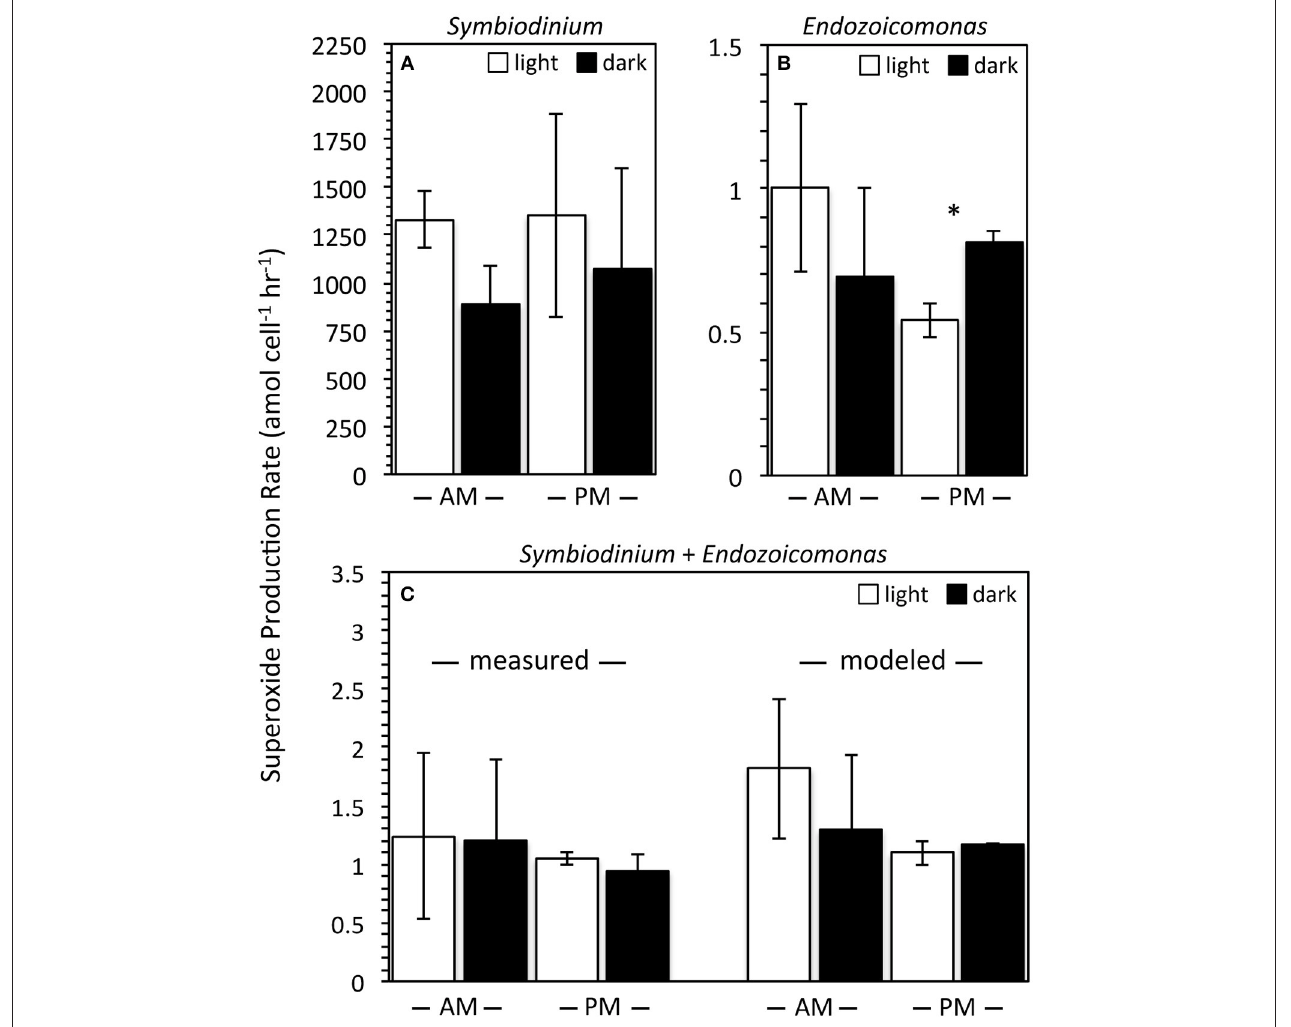
FIGURE 3 | Cell normalized extracellular superoxide production rates (mean ± SEM; n = 3) by Symbiodinium Clade A4 strain CCMP2456 and Endozoicomonas montiporae LMG24815 measured in isolation (A,B) and together (C) . Measurements were conducted in the light during the morning (white bars; PAR = ∼ 50 µ mol photon m − 2 s − 1 ; 9–11 am) and in the dark at night (black bars; PAR = 0 µ mol photon m − 2 s − 1 ; 10–11 pm). Symbiodinium + Endozoicomonas measurements are normalized to the total number of algal + bacterial cells. Predicted production rates of mixed cultures were calculated by adding individual rates for each organism. Note different scales for the y-axes. Significant differences ( p < 0.05) between day and night superoxide production rates are indicated by an